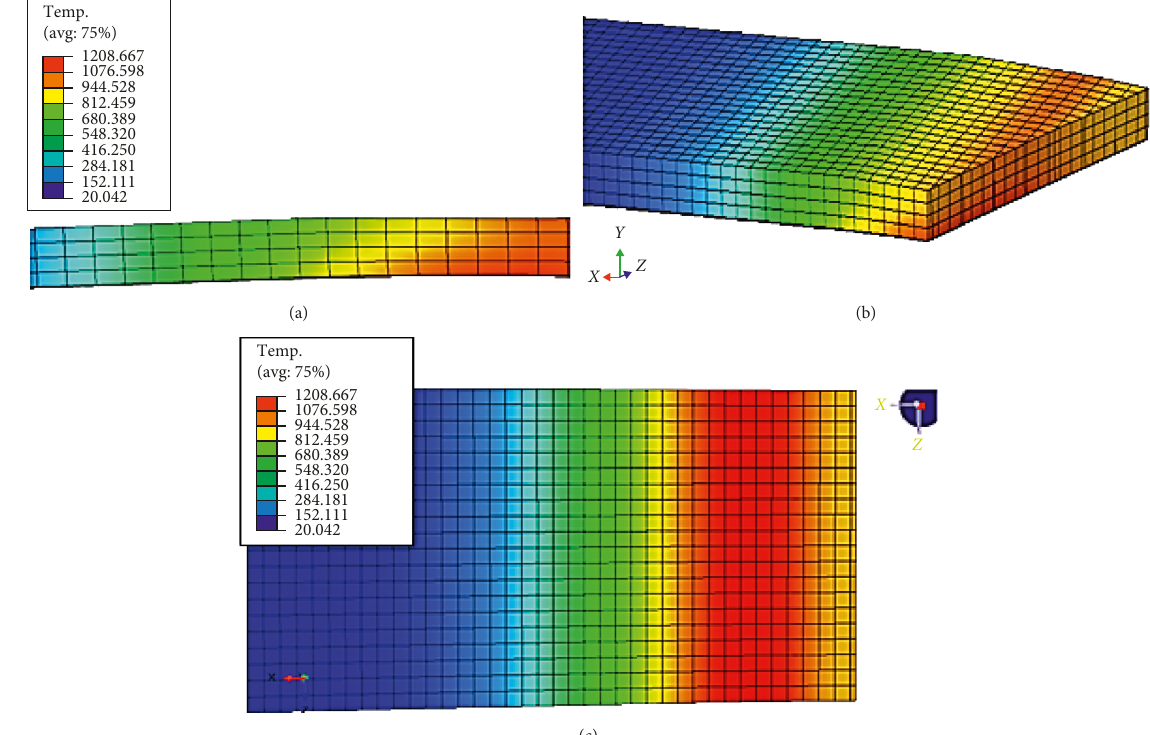
Figure 4: The general form of the temperature field of a steel strip in a thermal deformation hearth (a, b) and the distribution of thermal fields in the zone of the tape contact with the surface of the component (c) in the process of electrocontact surfacing at the outlet from the thermal deformation hearth t imp (cid:31)